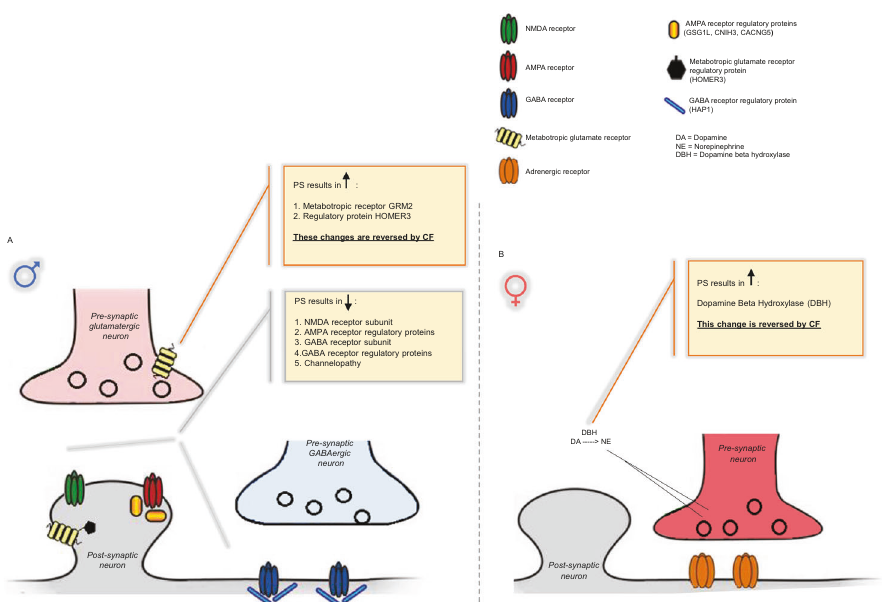
Fig. 5 Model summarizing gene expression changes in PS offspring and normalizations induced by CF. A In males, psychosocial PS results in downregulation genes encoding proteins associated with glutamatergic signaling, GABAergic signaling, and ion channel transporter complexes. These transcriptional changes associated with synaptic transmission are likely resulting in an imbalance in excitatory and inhibitory transmission, resulting in the behavioral abnormalities observed in PS males. CF to CTRL mothers normalizes gene expression changes associated with metabotropic glutamate receptor signaling and reverses anxiety-related behaviors. B In females, PS results in an upregulation of DBH, which is likely to increase noradrenergic tone and partially underlie HPA axis hyperactivity and increased anxiety noted in PS females. CF normalizes DBH expression and reverses anxiety-related behaviors in PS